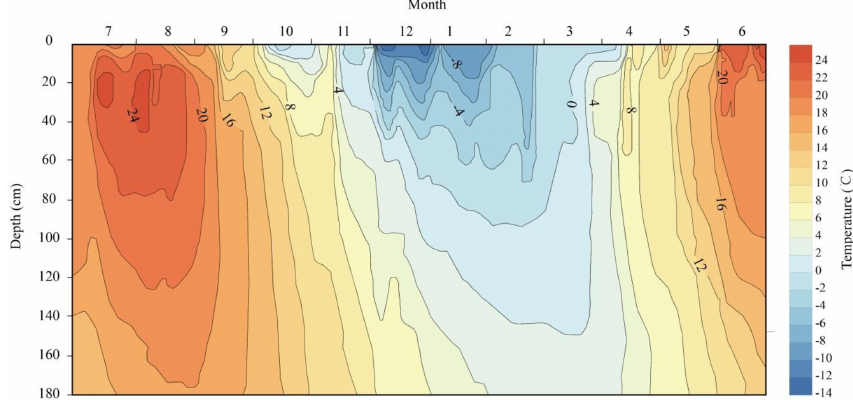
Figure 7. Annual variation of temperature ( ◦ C) within a shallow zone of a typical loess slope (Yang and Shao, 1995).